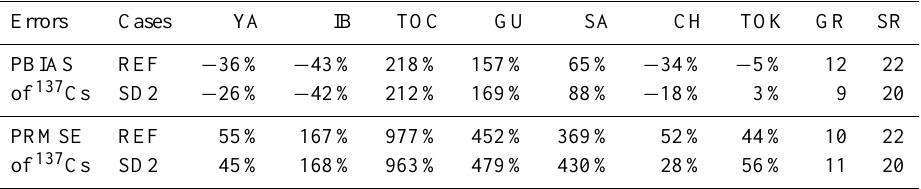
Table 10. The PBIAS and PRMSE of total daily depositions of 137 Cs with different size distribution of 137 Cs. GR represents the global ranks for PBIAS or PRMSE, and SR represents for the sum of the global ranks. The definition of GR and SR is shown in Sect. 3.1.2. “YA”, “IB”, “TOC”, “GU”, “SA”, “CH” and “TOK” represent the stations “YAMAGATA”, “IBARAKI”, “TOCHIGI”, “GUNMA”, “SAITAMA”, “CHIBA” and “TOKYO”, respectively.